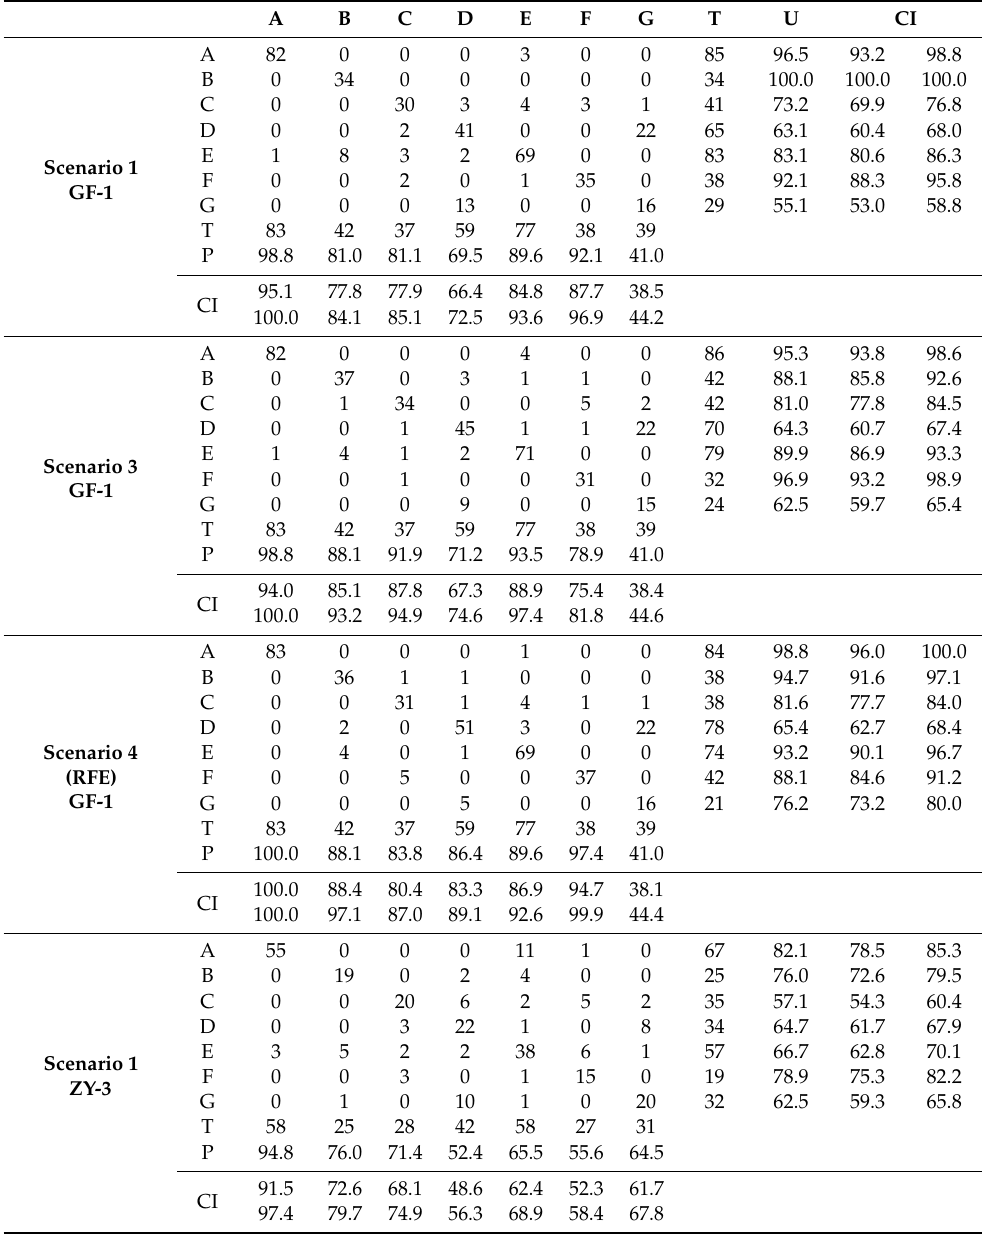
Table 11. Confusion matrix and associated classification accuracies based on testing data. A: forest; B: cropland; C: deep-water herbaceous vegetation; D: shallow-water herbaceous vegetation; E: shrub; F: open water; G: paddy field. T, total sample; P, producer accuracy (%); U, user accuracy (%); CI, 95% confidence interval